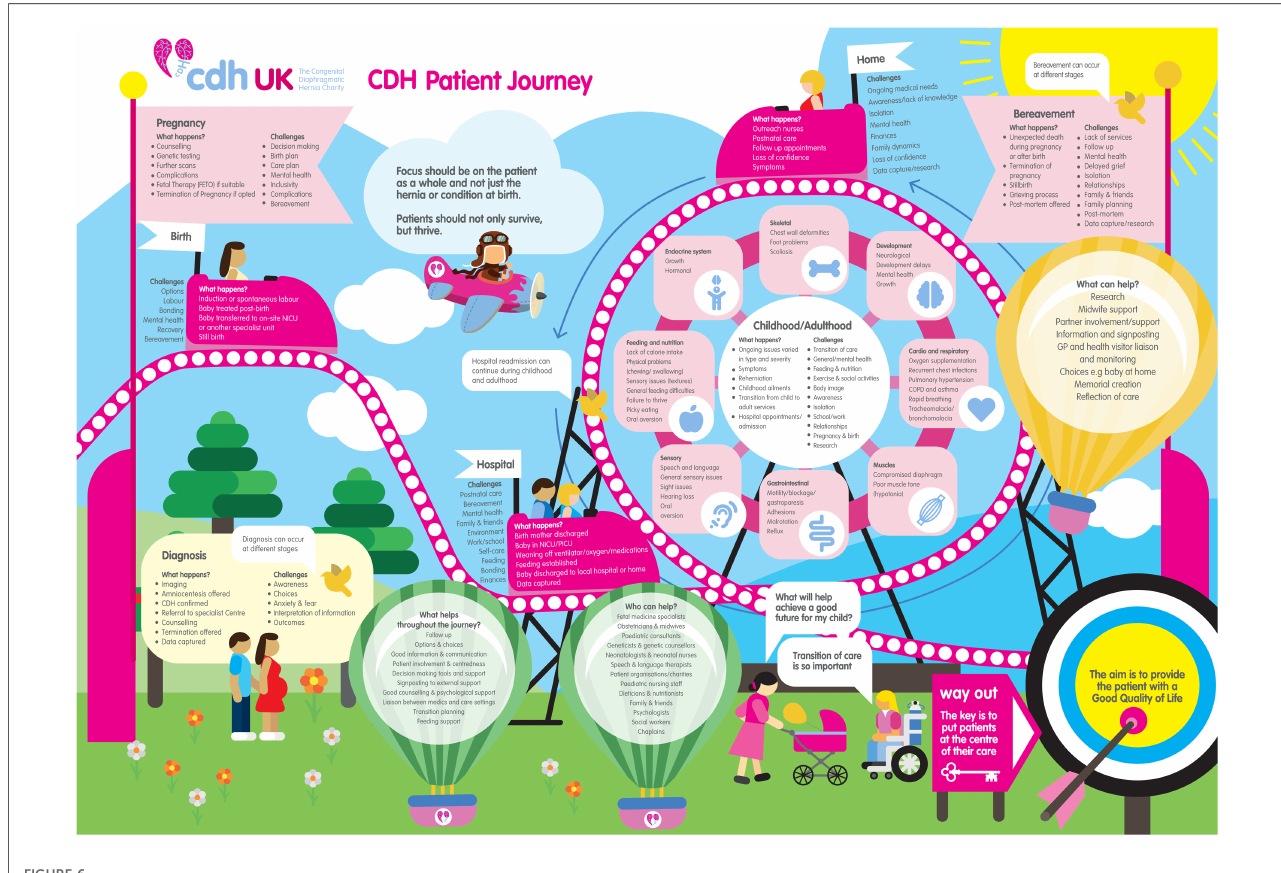
FIGURE 6 CDH Patient Journey V1